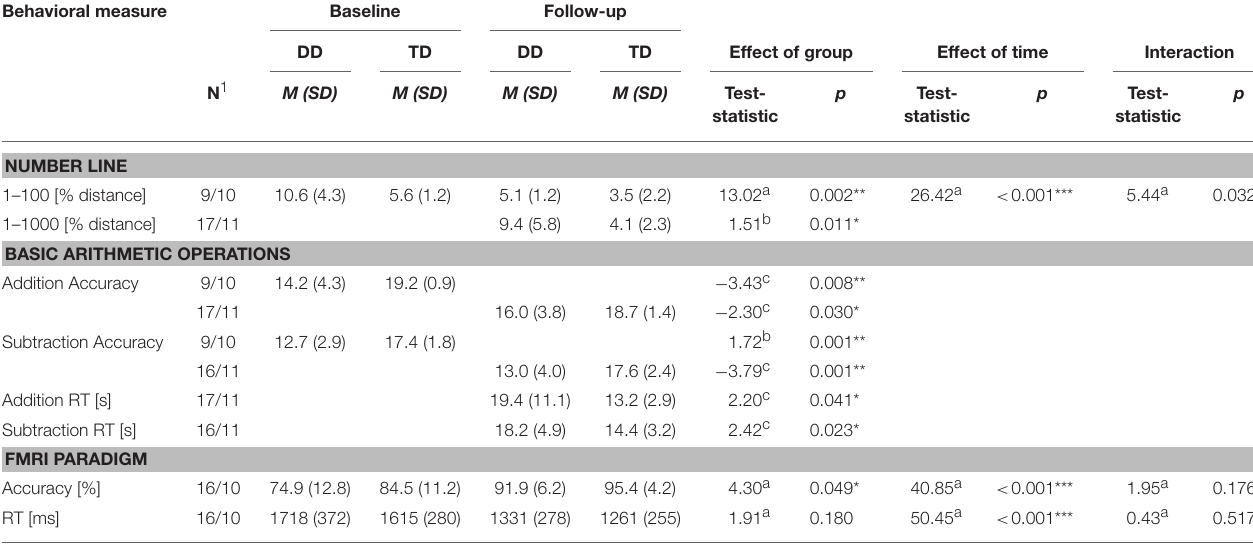
TABLE 2 | Behavioral results for the spatial representation of numbers (number line), basic arithmetic operations (addition and subtraction), and the fMRI paradigm. Behavioral measure Baseline